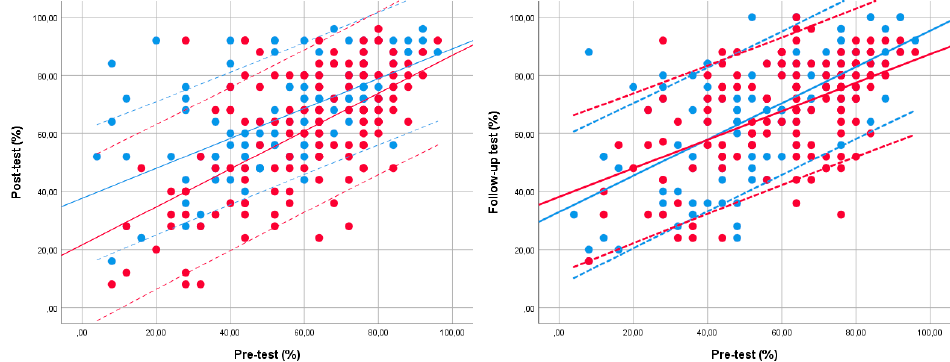
Figure 3. Comparison of student performance on the pre- and post-tests and on the pre- and follow-up tests.